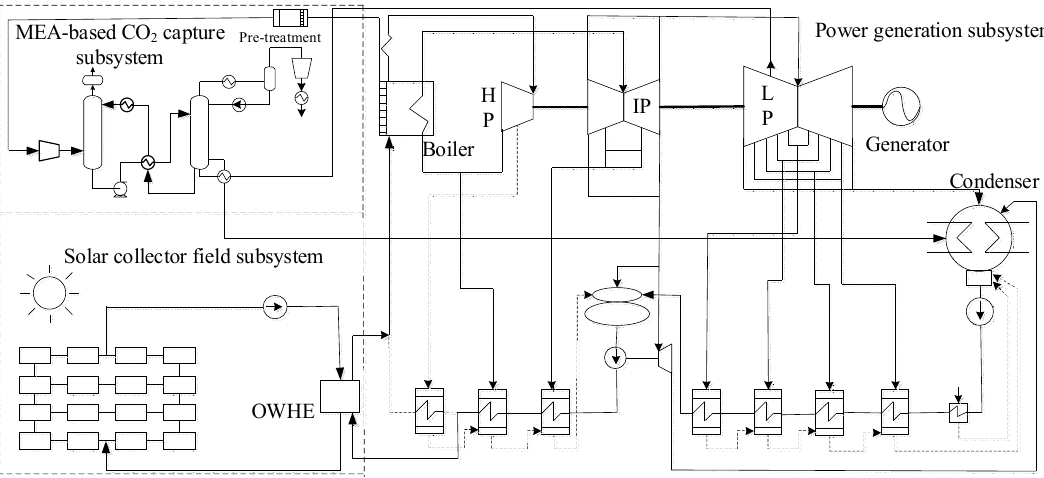
Figure 2. Solar-aided coal-fired power generation with CO 2 capture (SA-PG-CC) system.